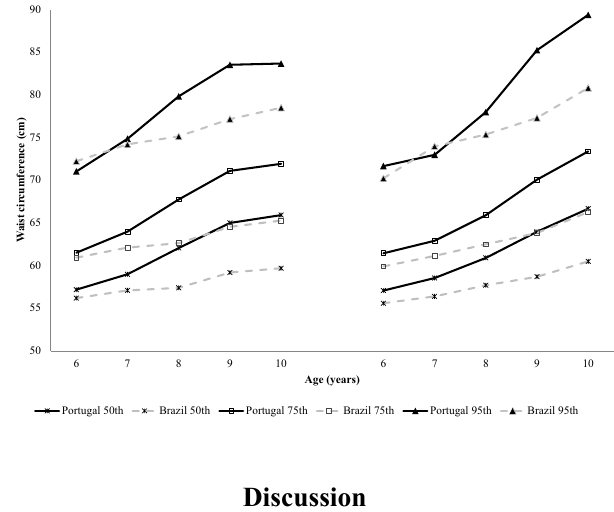
Figure 3: Comparisons of age and sex in the 50th, 75th and 95th per- centiles for waist circumference of Portuguese and Brazilian